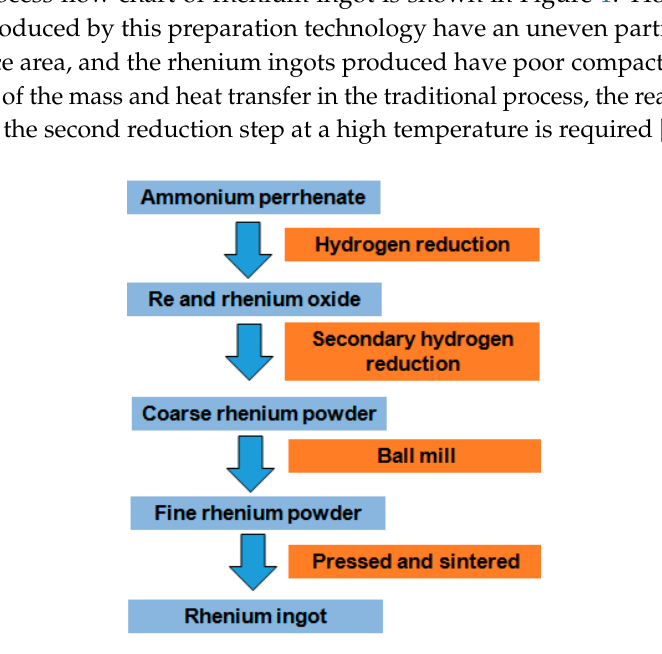
Figure 1. Industrial preparation of rhenium ingots.